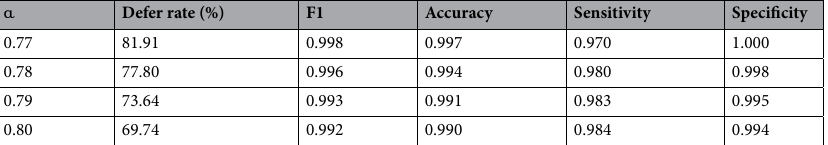
Table 1. Performance metrics of the LDU algorithm in the diagnosis of pleural effusion, by setting the weight of defer loss between 0.77 and 0.80.